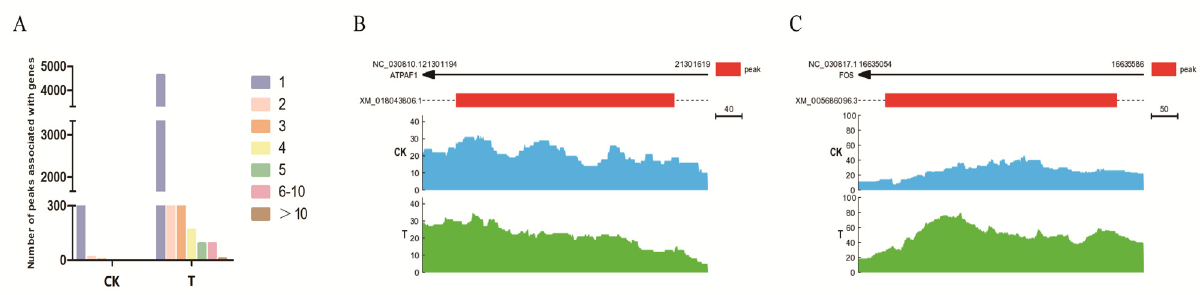
Figure 5. Analysis of specific peak-related genes in the CK and T groups. ( A ) Statistics for the peak numbers of genes in the different groups. ( B ) Visualization of the CK group-specific peak-related gene, ATPAF1. ( C ) Visualization of the T group-specific peak-related gene, FOS.